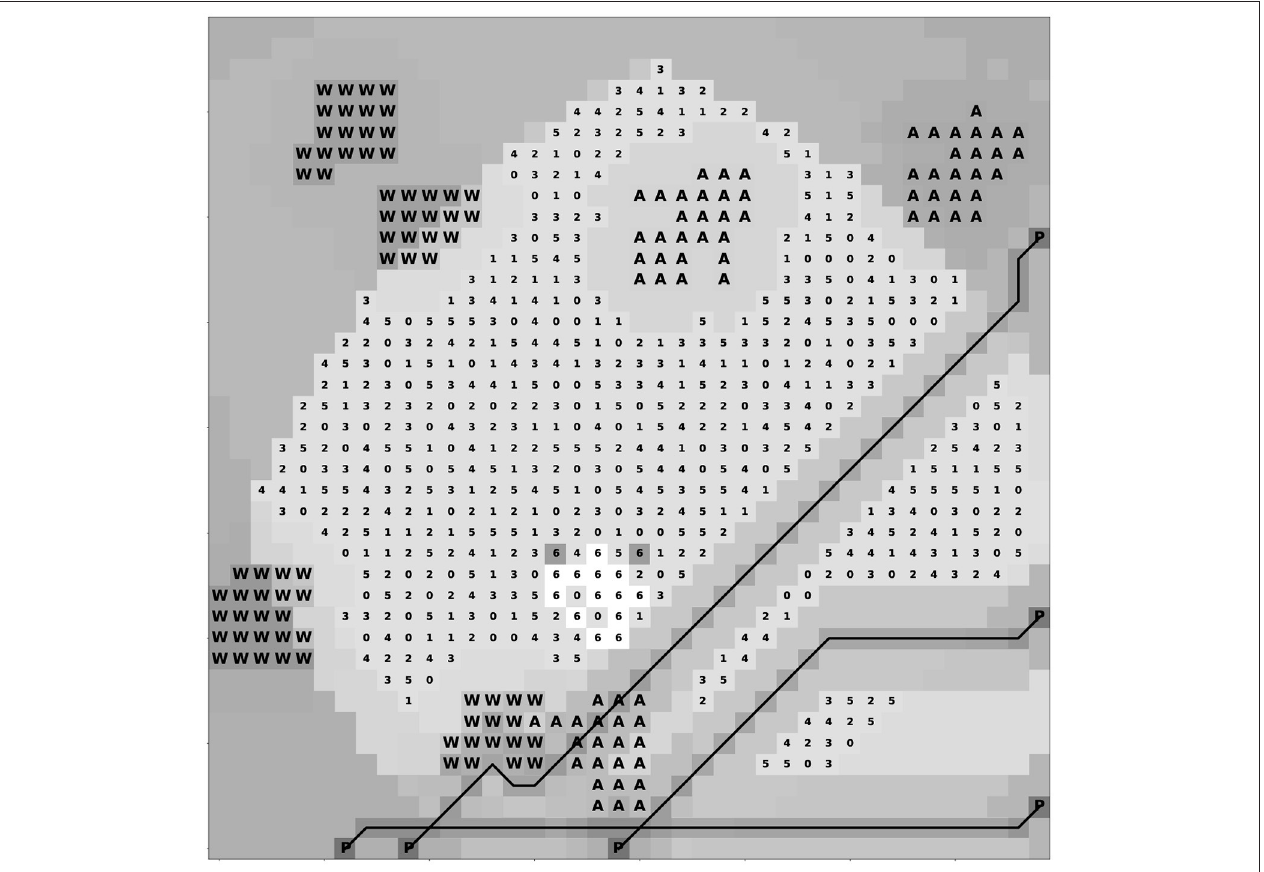
FIGURE 7 | The sample validity map with one compact